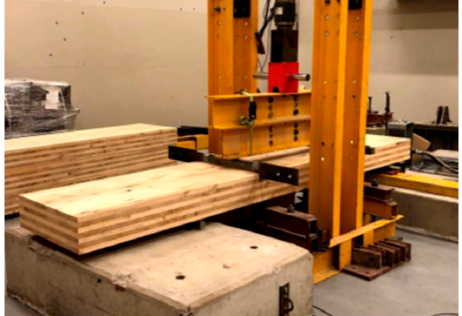
Figure 2. Rolling shear strength and stiffness tests derived from short span bending tests on E. nitens CLT panels.